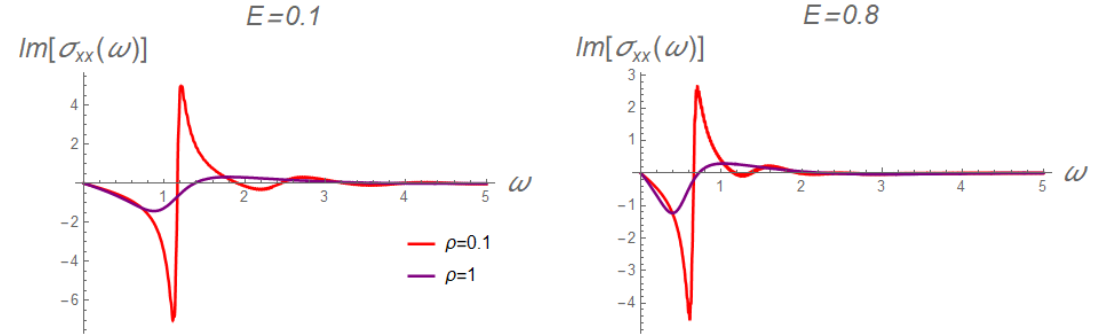
Figure 8 . Imaginary part of the longitudinal (cid:27) xx conductivity in the case E < B (non-symmetric phase).